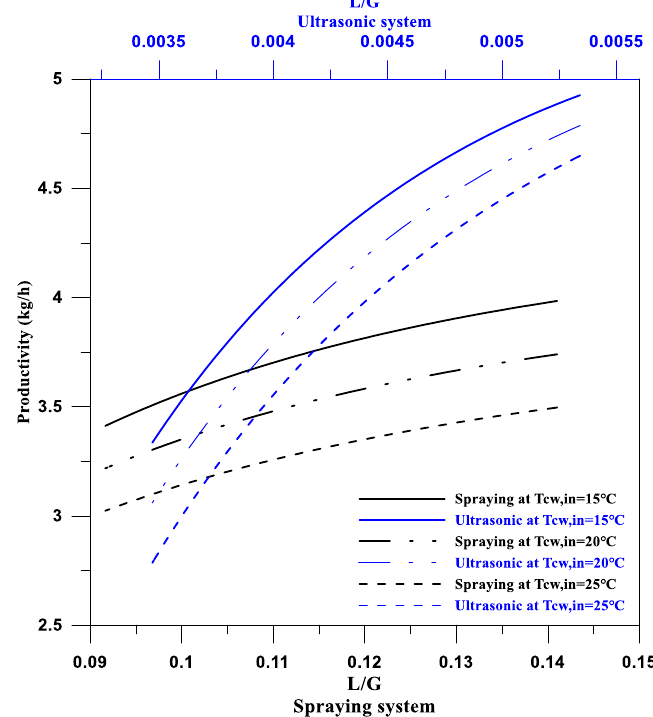
Figure 9. Productivity of traditional spraying system and ultrasonic water atomizer at different T cw,in.